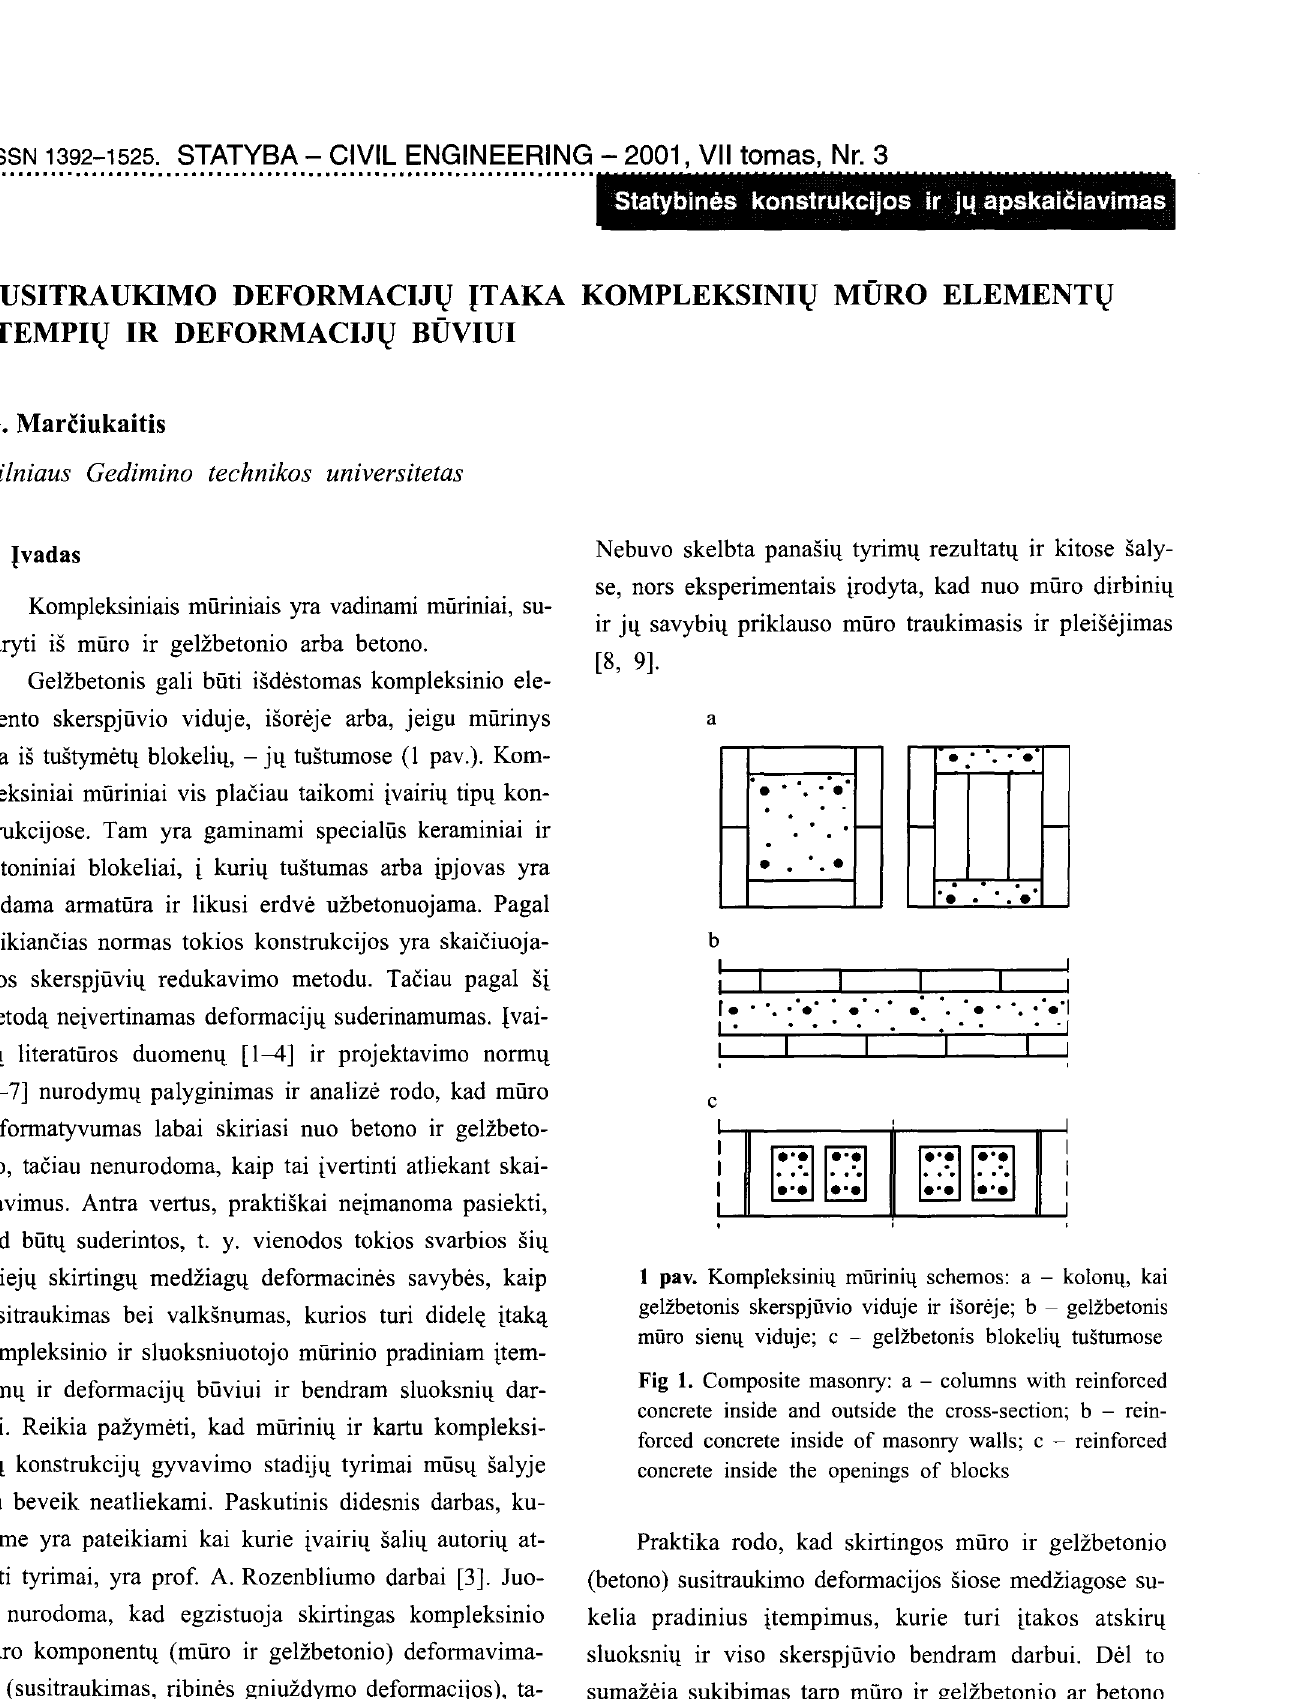
muro sienll viduje; c - gelzbetonis blokelill tustumose Fig 1. Composite masonry: a - columns with reinforced concrete inside and outside the cross-section; b - rein forced concrete inside of masonry walls; c - reinforced concrete inside the openings of blocks Praktika rodo, kad skirtingos miiro ir gelzbetonio (betono) susitraukimo deformacijos siose medziagose su kelia pradinius itempimus, kurie turi itakos atskirll sluoksnill ir viso skerspjuvio bendram darbui. Del to